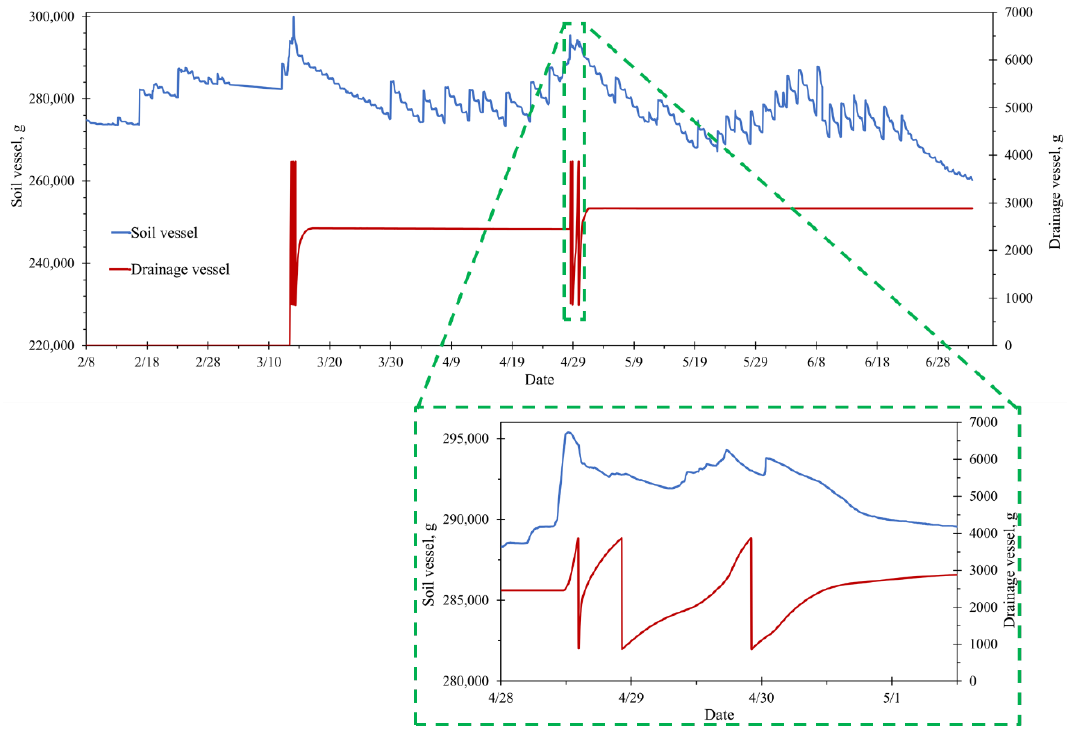
Figure 3. Mass variations of the two lysimeter vessels during 2017.